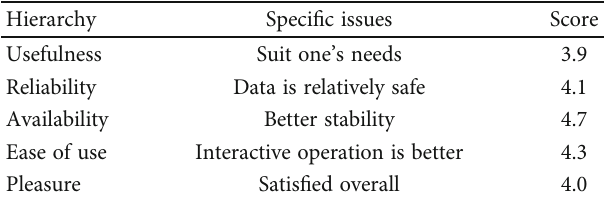
Table 1: Subject experience evaluation of existing erotic movies.